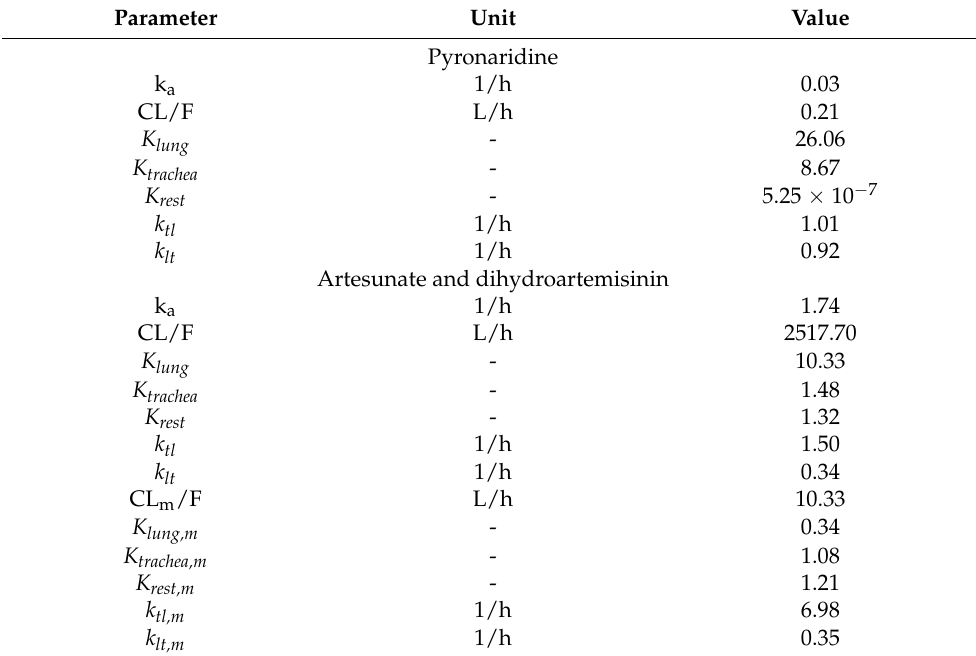
Table 2. Biochemical parameters of pyronaridine, artesunate, and